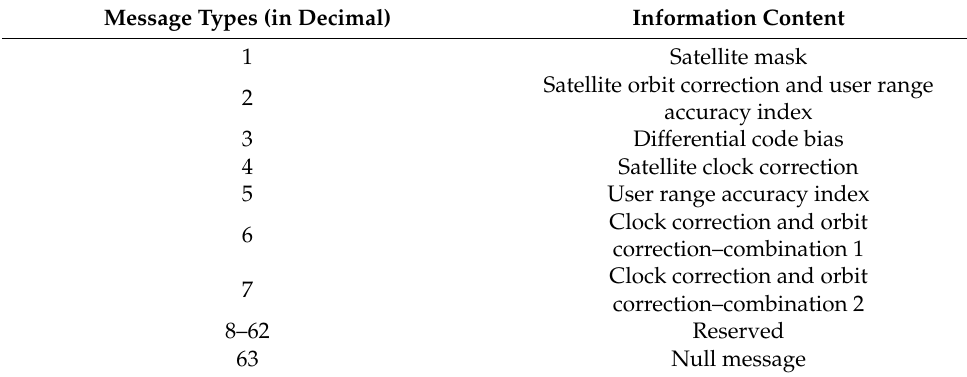
Table 1. Defined message